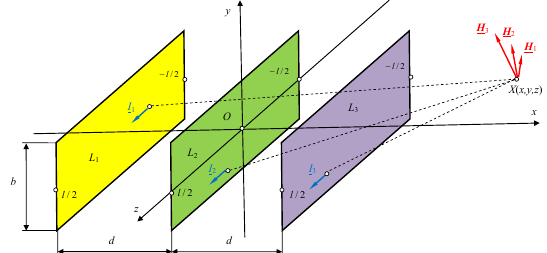
Fig. 4. The three-phase line of three ribbon conductors of finite length.